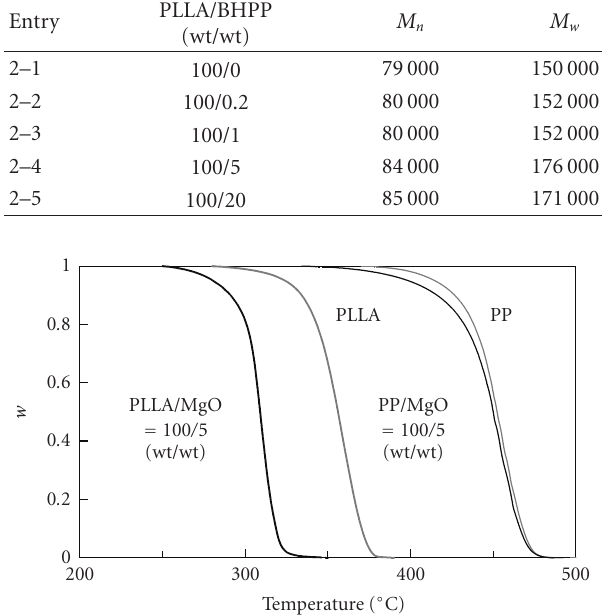
Table 3: Changes in weight and molecular weight of PLLA in PLLA/BHPP blends after heating at 300 ◦ C for 30